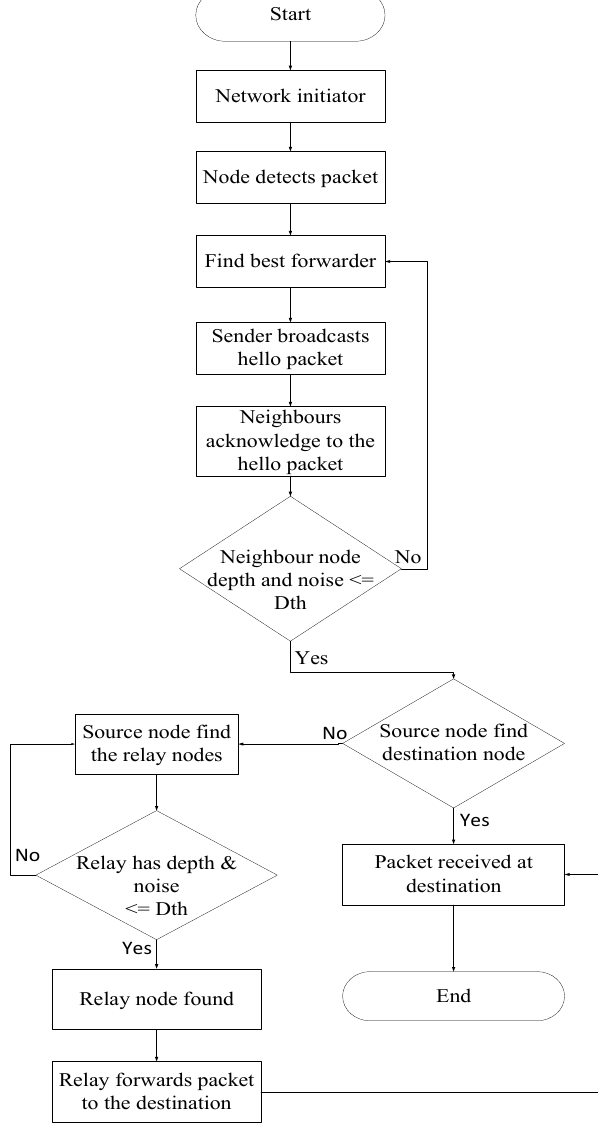
Figure 10. Flow chart showing the working mechanism of